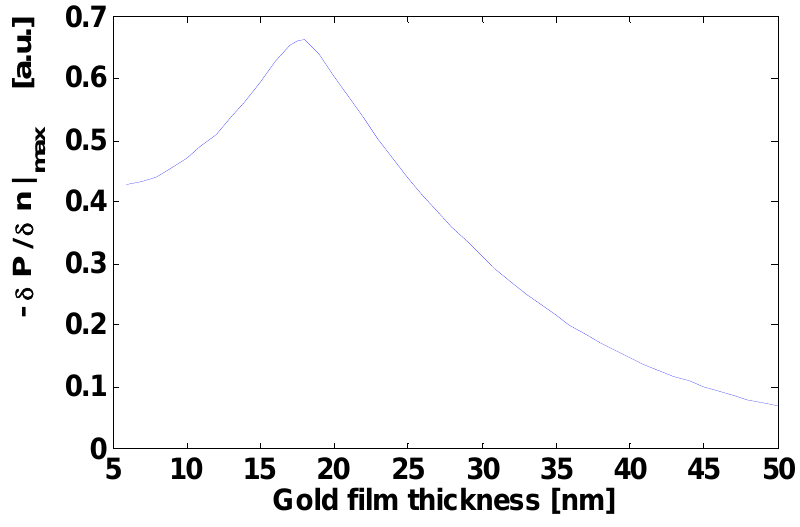
Figure 5. Power dependence (slope) from refractive index as a function of gold layer thickness (Cr film adhesion layer fixed at 6 nm).